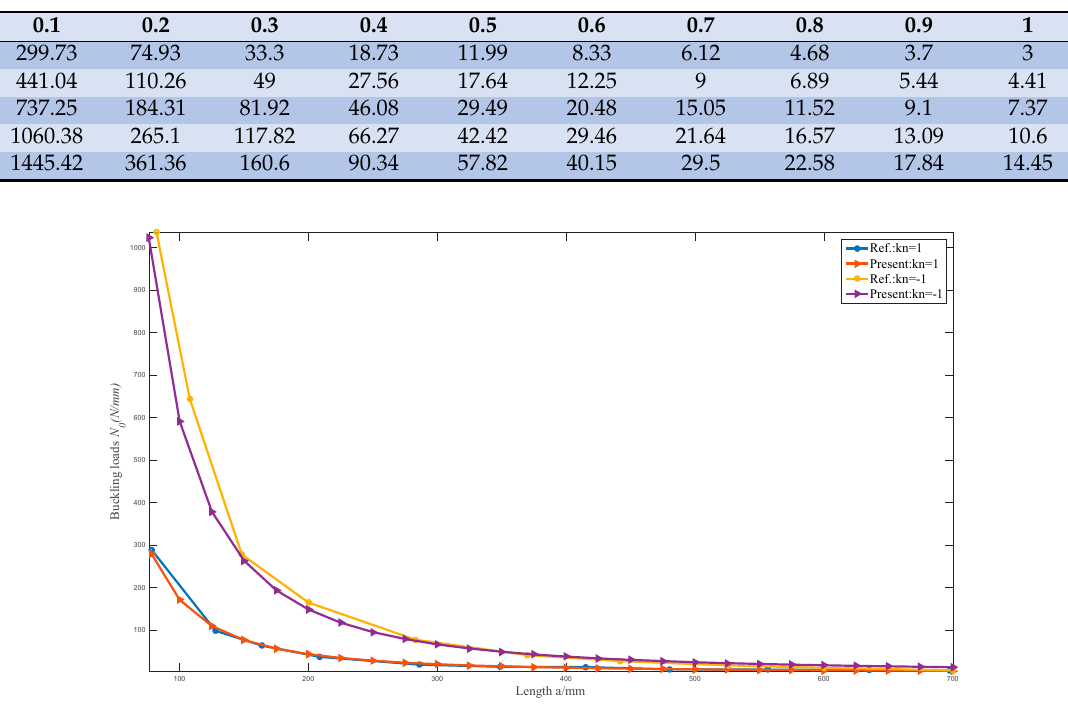
Figure 12. Validation.